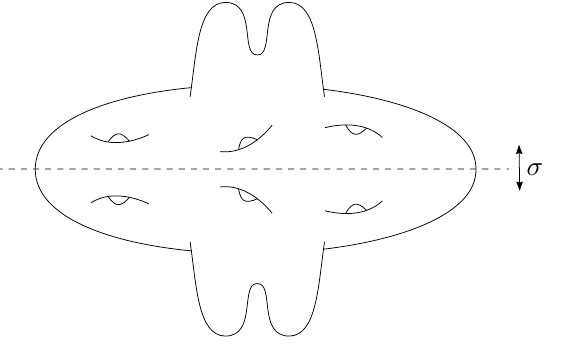
Figure 2 . The double conifold with asymptotic U(1) R symmetric regions.